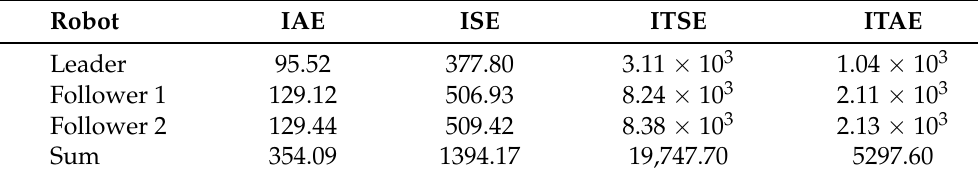
Table 6. Performance indexes for the IPC algorithm in the formation control experiment.